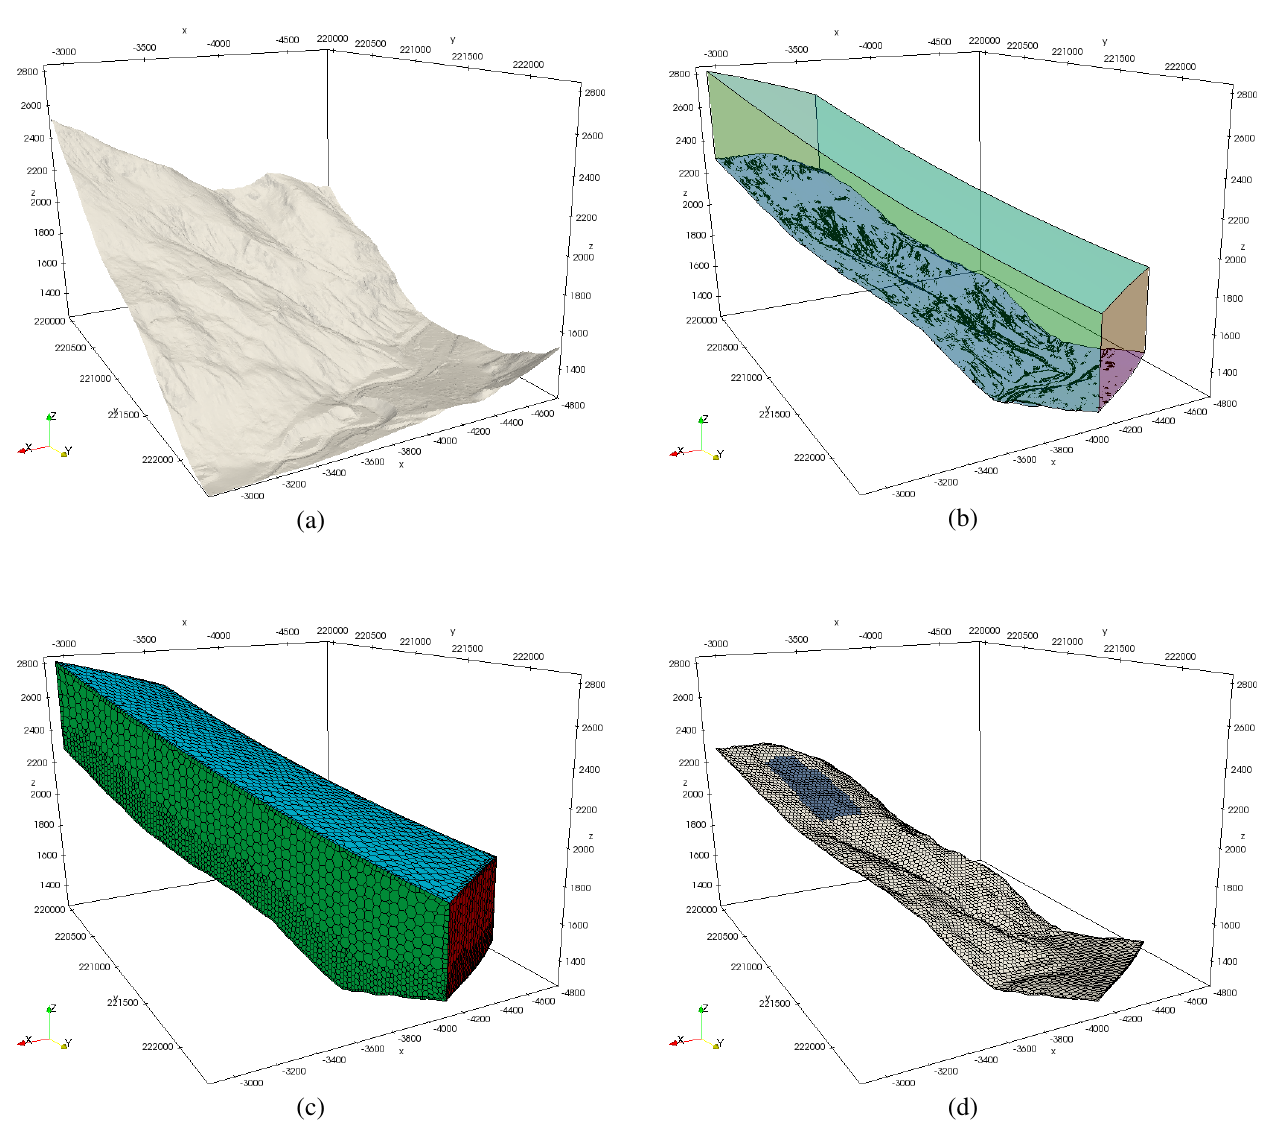
Figure 3. Meshing tool chain: the terrain data are usually available as raster data (a) . Triangulation of the relevant area and adding walls and a top boundary yields a closed triangulated surface ( b ; sharp edges are highlighted black). This surface can be processed by most meshing tools; here, we apply cfMesh to get a polyhedral-dominated finite-volume mesh (c) . The bottom boundary surface of the finite-volume mesh builds the foundation for the finite-area mesh used for simulations (d) . Note that we show a very coarse mesh for the sake of visibility of the edges. Terrain data: Amt der Tiroler Landesregierung (AdTLR). EPSG coordinate reference system: